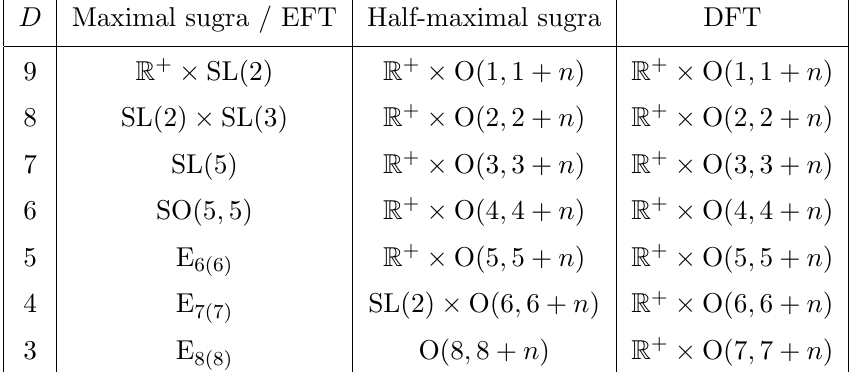
Table 1 . Relevant duality groups in maximal and half-maximal supergravity as well as in extended (cid:12)eld theory. Only the non-chiral N = (1 ; 1) supergravity in D = 6 is displayed. The R + factor in the duality structure of DFT is actually a combination of an internal R + contained in the second column and a trombone